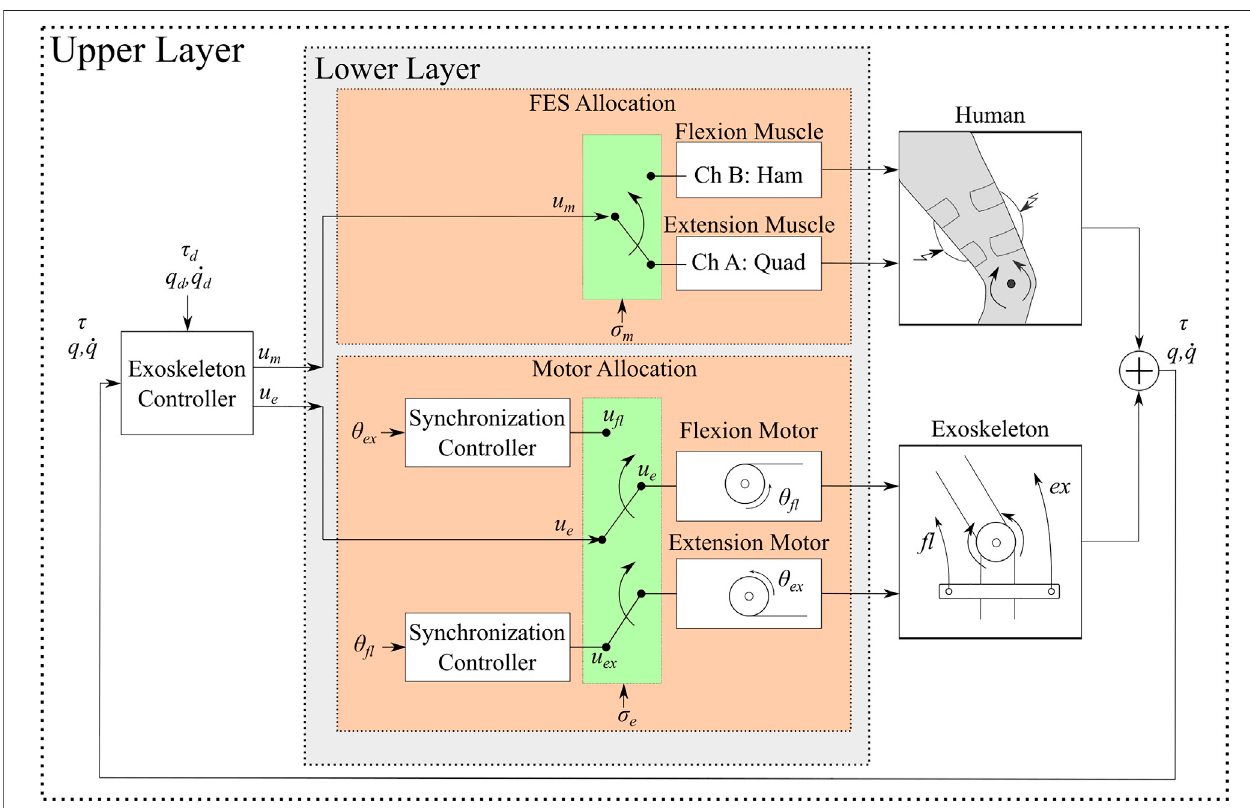
FIGURE 3 | Block diagram of the two-layer control scheme. The upper layer is the joint feedback loop to generate the muscle and motor control inputs u m and u e , respectively. The muscle and motor inputs can exploit kinematic or torque feedback. The lower layer allocates the upper layer control inputs u m , u e toindividual muscles and motors. The allocation is dictated by the switching signals σ m , σ e to apply FES and electric currents, respectively. Within the lower motor layer, a synchronization controller is designed to maintain suitable cable tension and avoid cable slackness.